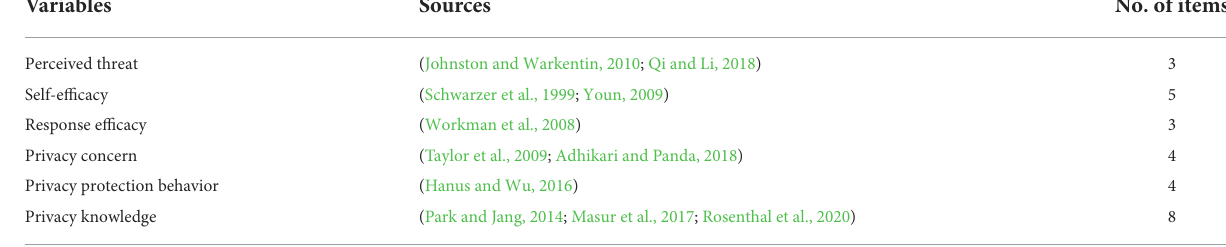
TABLE 1 Research variables and sources.